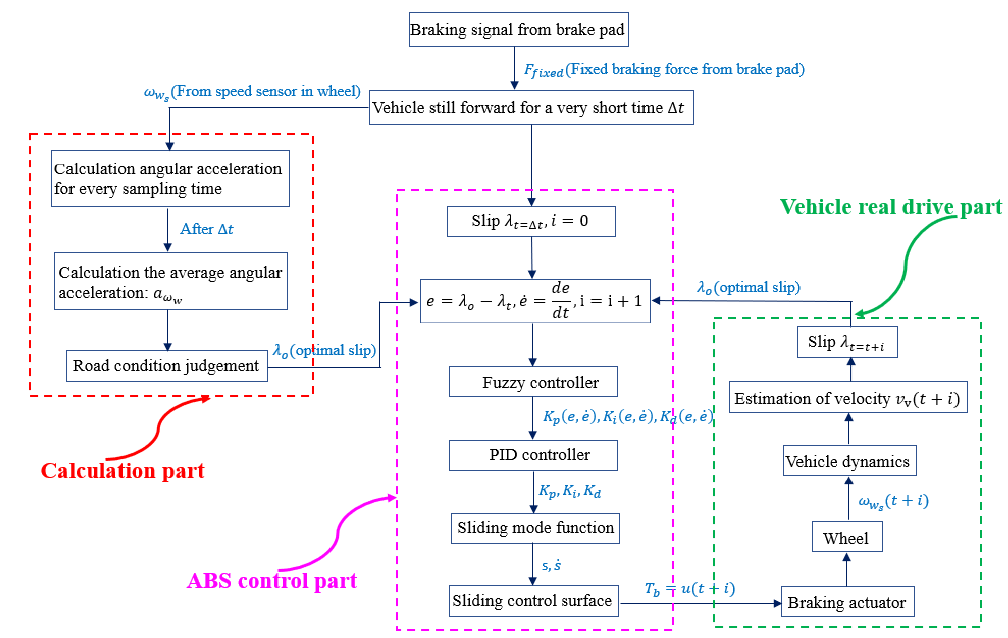
Figure 3. Control flow for single